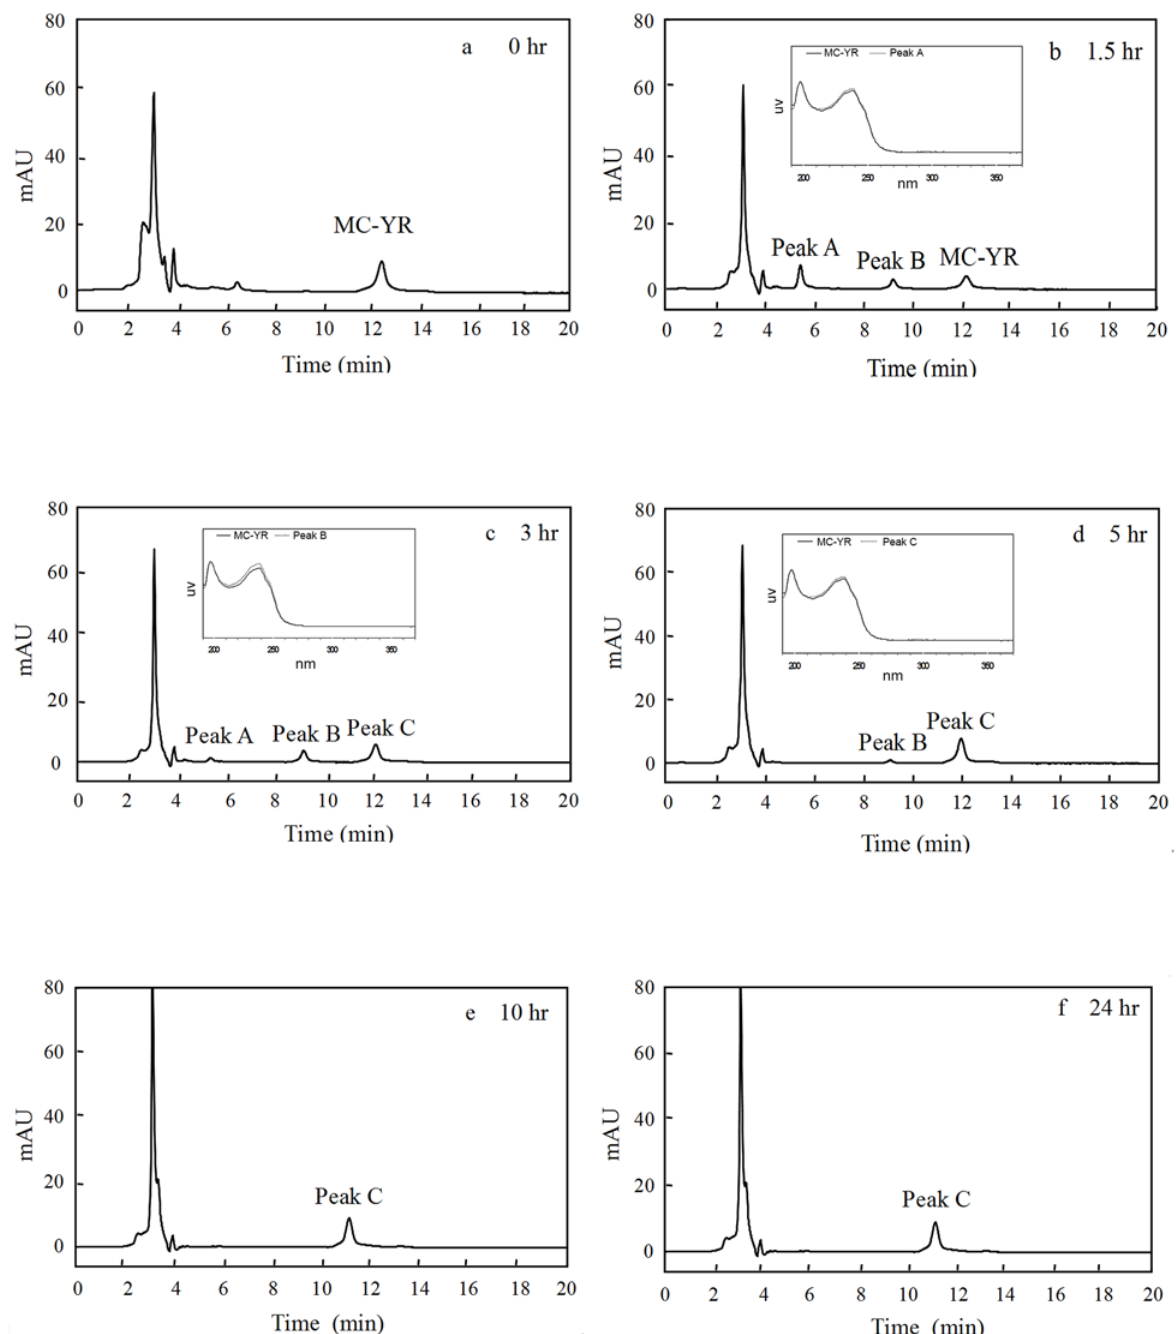
Fig 2. Enzymatic biodegradation of MC-YR by CEs of USTB-05 with time course and the scanning profiles of MC-YR and its products at the ultraviolet wavelength from 200 nm to 370 nm.